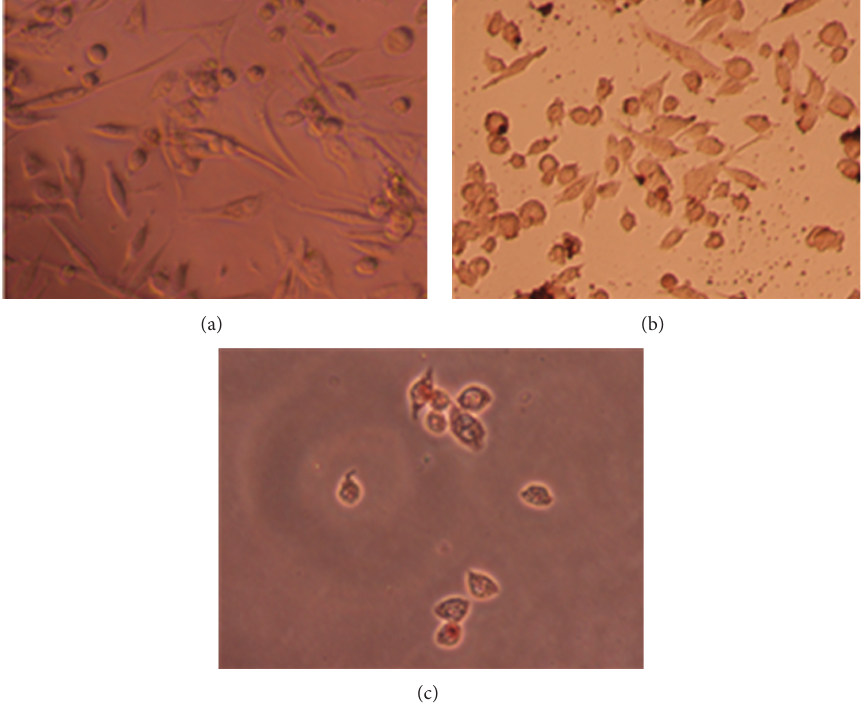
(b) g/mL (50 growth SEM of three independent 𝜇𝜇 % ±